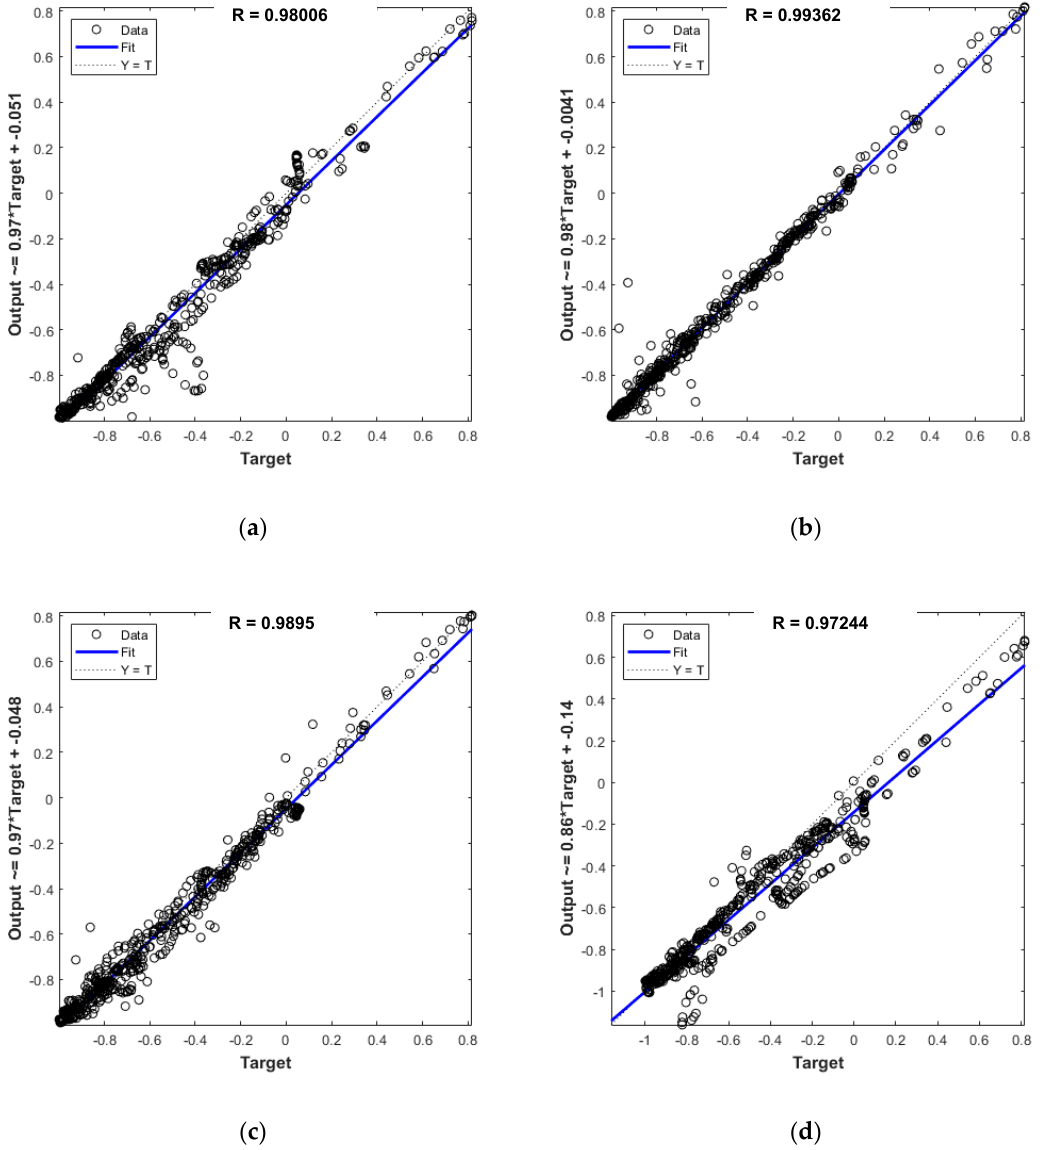
Figure 12. Regression plots of predictions for the NIRSpec use case with 35 sensors: ( a ) frequency-dependent ANN, ( b ) NARX, ( c ) ANN with biLSTM layer, and ( d ) pretrained ANN. The output values and the target values are normalized.